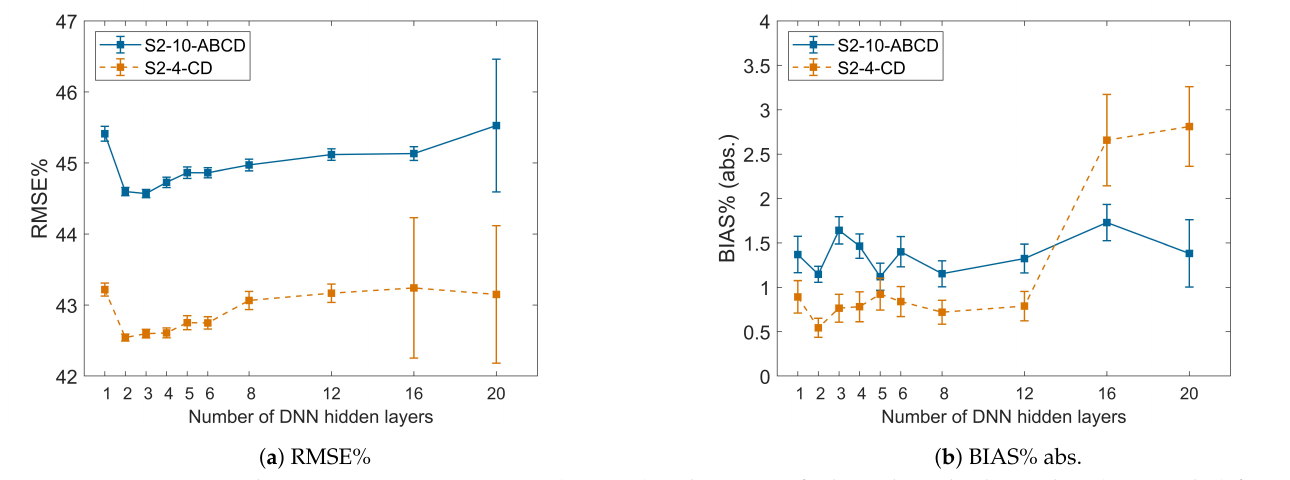
Figure 5. Test set relative root-mean-square error (RMSE%) and average of relative bias absolute values (BIAS% abs.) for DNN models with different numbers of DNN hidden layers. Blue: model with ten S2 image channels and all auxiliary features. Orange: model with four S2 image channels, DEM, and slope information as input features. S2 image sampling with 3 × 3 pixels in each model. The whiskers show the 99% confidence intervals from 100 modeling